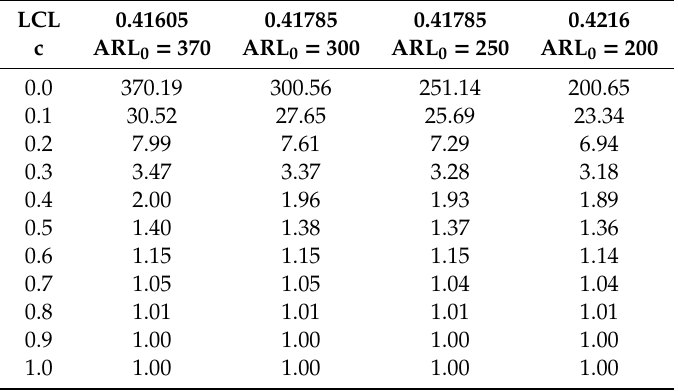
Table 5. The ARLs for the proposed chart when n = 25, WD (1.0,1.3), USL = 6.8878, and LSL = 0.0065.